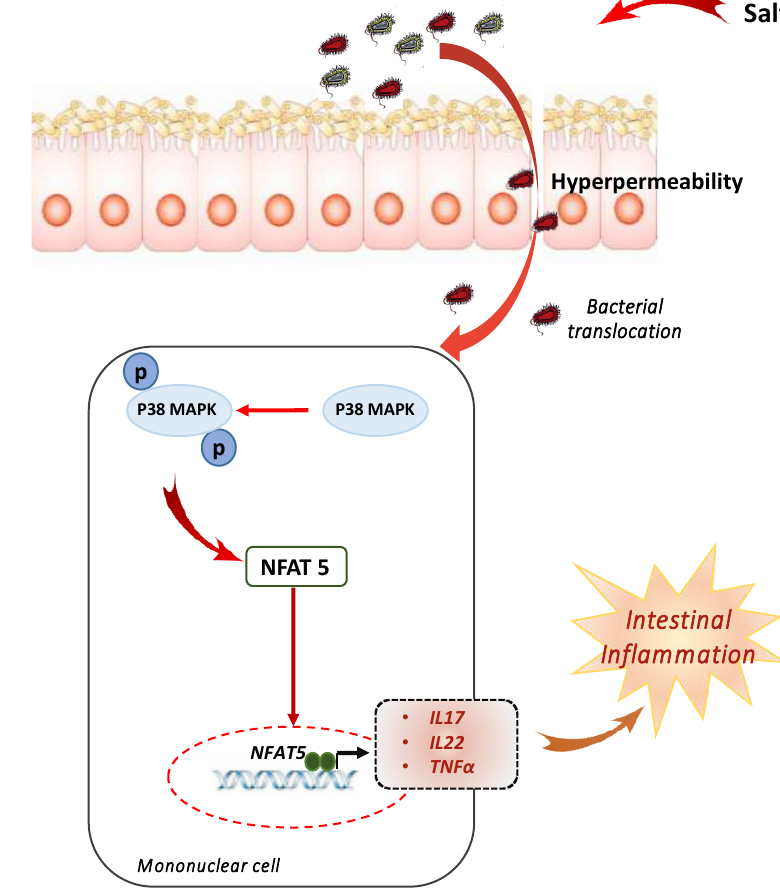
Figure 1. High-salt diet promotes intestinal inflammation. High-salt diet exposure led to higher intestinal permeability and dysbiosis. High-salt diet induced p38 MAPK phosphorylation and NFAT5 in lamina propria mononuclear cells activation with a subsequent expression of inflammatory cytokines expression such as IL17, IL22, and TNFα.